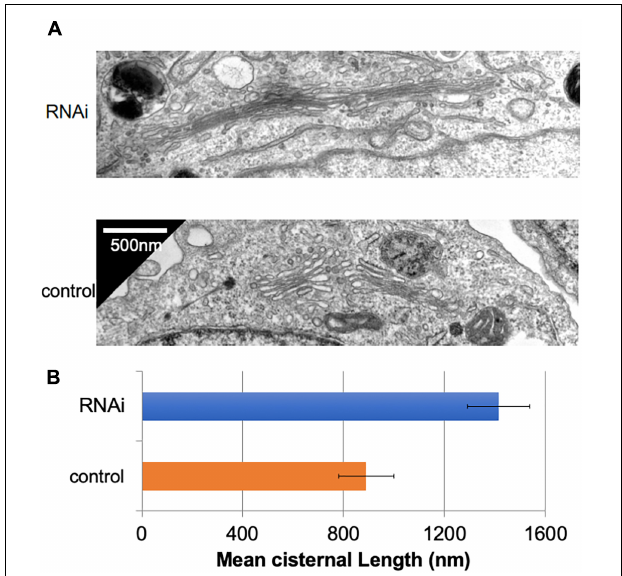
FIGURE 1 | Loss of Giantin elongates Golgi cisternae. (A) Typical electron micrographs of Golgi cisternae in Giantin and control siRNA-treated cells. Bar, 500 nm. (B) Cisternal lengths were measured by tracing the cisternae manually using ImageJ software ( B , n = 10 micrographs, bar, SEM, P <